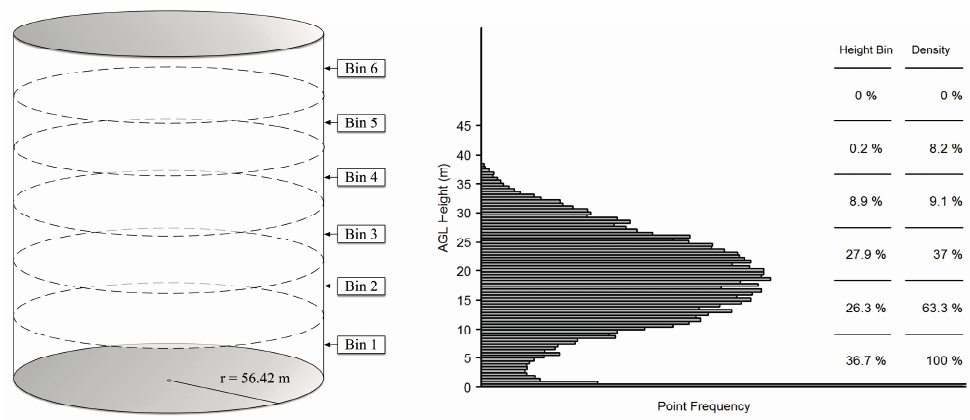
Figure 4. Conceptual illustration of the separation of vertical space ( left ), and example of the vertical distribution and separation (by metric type) of light detection and ranging (LiDAR) returns in a hectare plot ( right ).